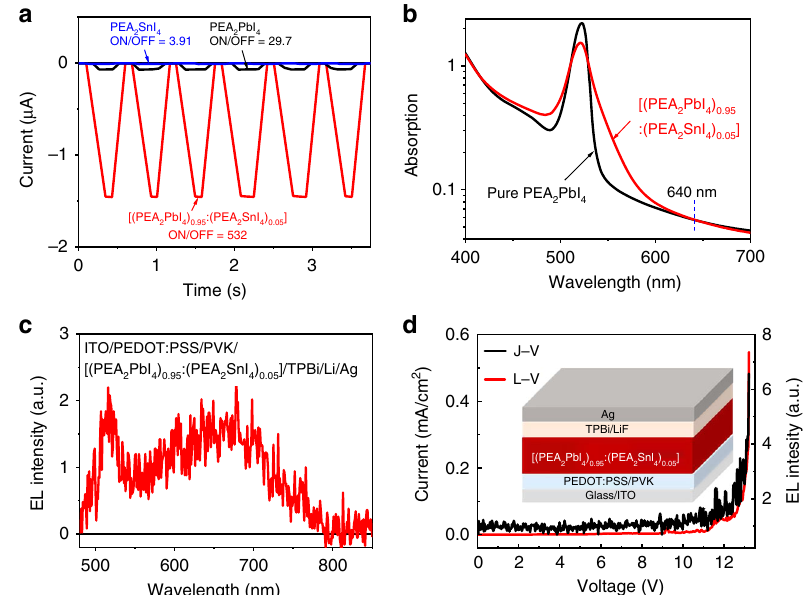
Fig. 5 Device performance of photodetectors and LEDs for 2D perovskite heterostructures. a The ON – OFF behaviors of heterostructured 2D perovskite [(PEA 2 PbI 4 ) 0.95 :(PEA 2 SnI 4 ) 0.05 ] photodetector (red) as compared to pure PEA 2 PbI 4 (black) and PEA 2 SnI 4 (blue) devices when exciting at 640 nm (1000 mW/cm 2 ). b Absorption spectra of two fi lms. c EL spectrum containing broad CTE emission and host emission. d Current density – voltage – EL curve of doped device. The device structure is shown as the